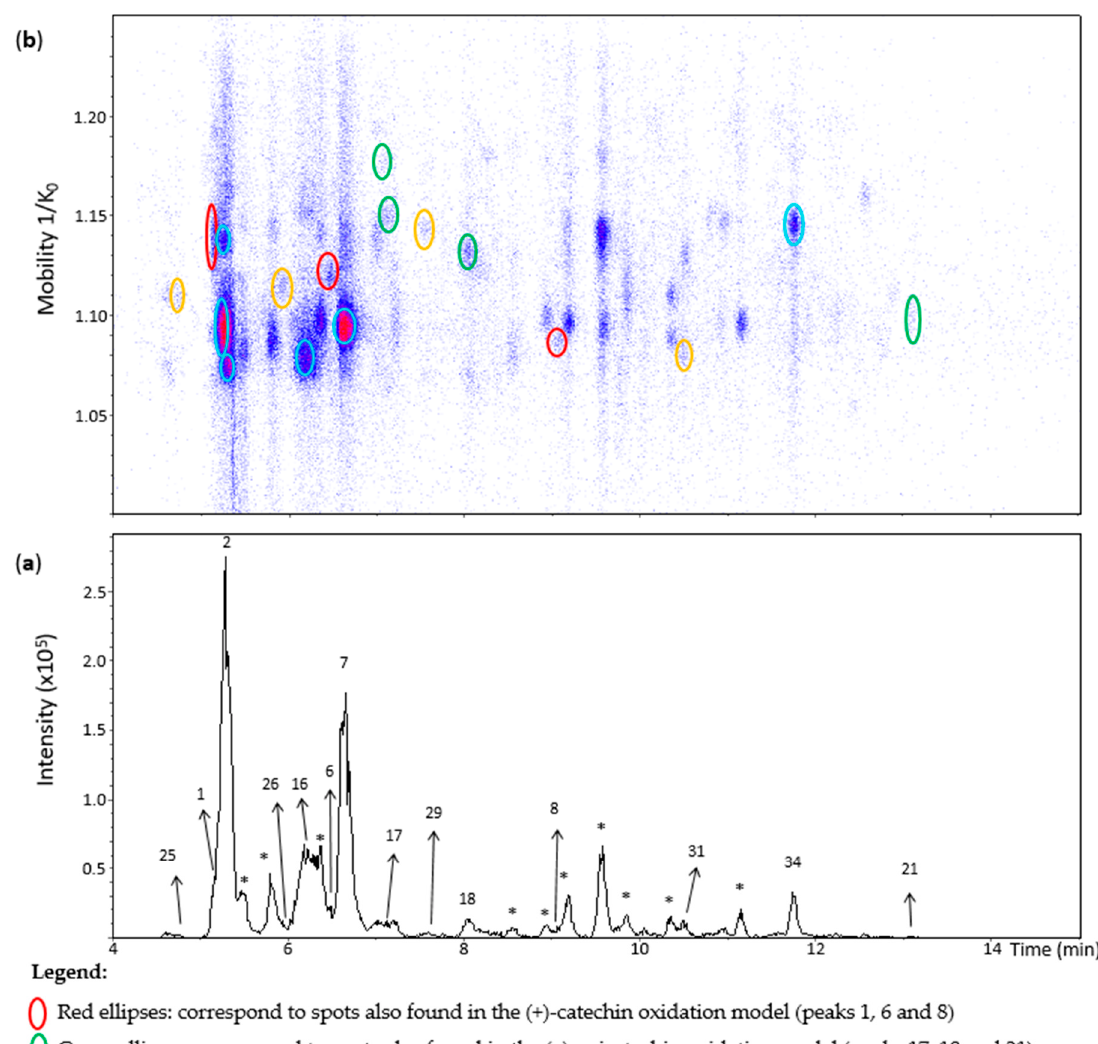
Figure 8. UHPLC − ESI ( − ) − TIMS − QTOF − MS/MS analysis of grape seed extract. ( a ) EIC from the mass range of m / z 577.1–577.2; ( b ) heat map showing the mobility versus Rt for the mass range of m / z 577.1–577.2. Full details on peak numbers are available in Table S2. * Indicates peaks showing an MS/MS fragmentation pattern that corresponds to dimeric procyanidin compounds. Ellipses on the heat map mark the main spots.